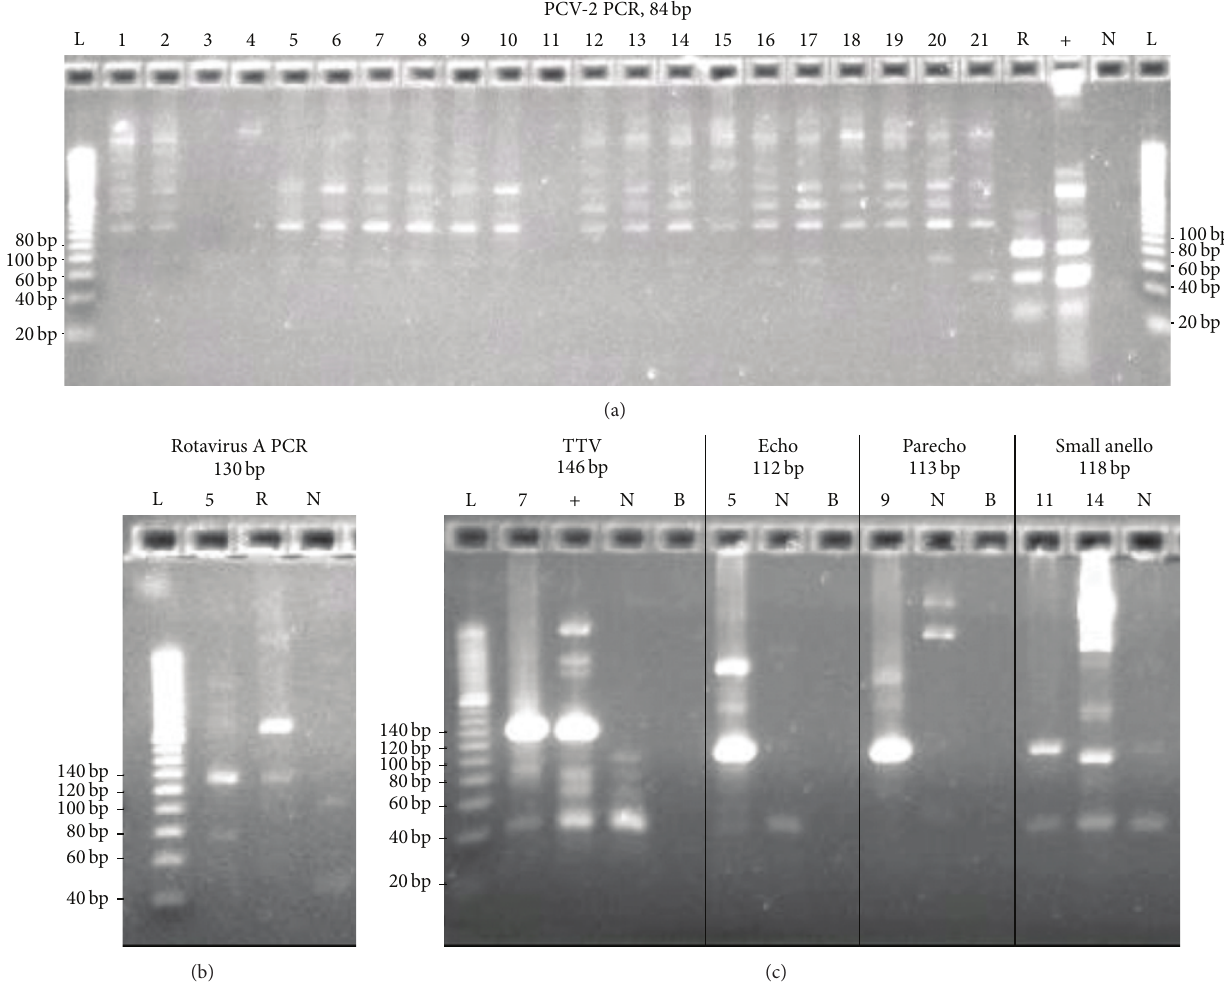
Figure 2: Results of PCR confirmation of PCV-2, rotavirus A, parechovirus, echovirus, TTV, and small anellovirus from selected samples. (a) PCV-2 PCR. Lanes 1–21 are human ileum samples. R: RotaTeq vaccine; +: PK-15 cell control; N: NTC; L: 20bp ladder. Both RotaTeq and positive control gave expected size at 84 bp. (b) Rotavirus A PCR. Sample 5 and RotaTeq gave expected band at 130 bp. No product was detected in NTC. (c) PCR results of TTV, Echovirus, parechovirus, and small anellovirus. B: blank. Sample 7 and a positive control from a previous study gave expected band size at 146bp. Echovirus PCR from sample 5 detected an expected band size at 112bp. Parechovirus PCR from sample 9 detected an expected band size at 113bp. Small anellovirus PCR from samples 11 and 14 produced expected band size at 118bp.